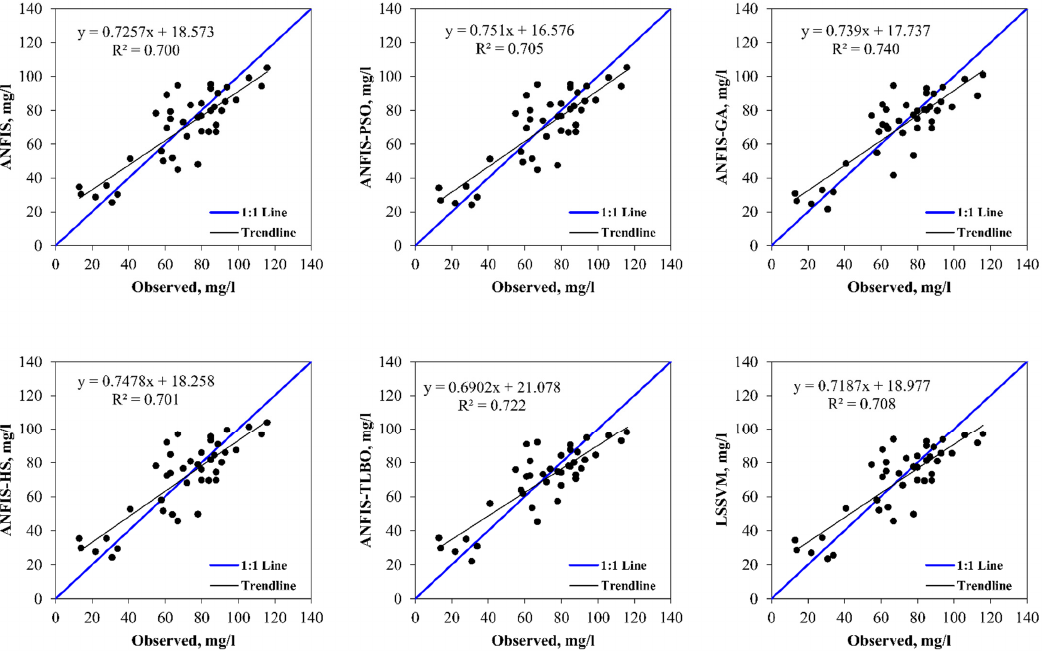
Figure 3. The observed and model-estimated CODs for the M2 data set with AMM, TKN, and WT as inputs.